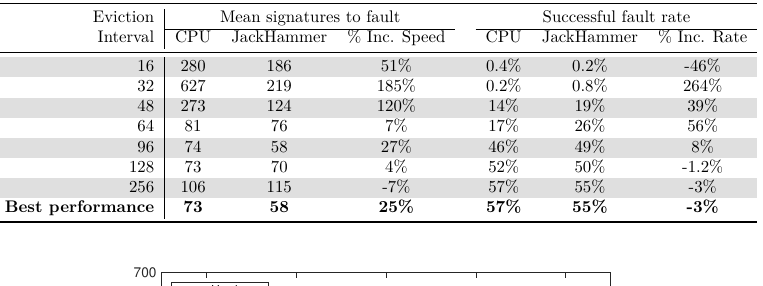
Table 2: Performance of our JackHammer exploit compared to a standard software CPU Rowhammer with various eviction intervals. JackHammer is able to acheive better performance in many cases because it bypasses caching architecture, sending more memory requests during the eviction interval and causing bit flips at a higher rate.